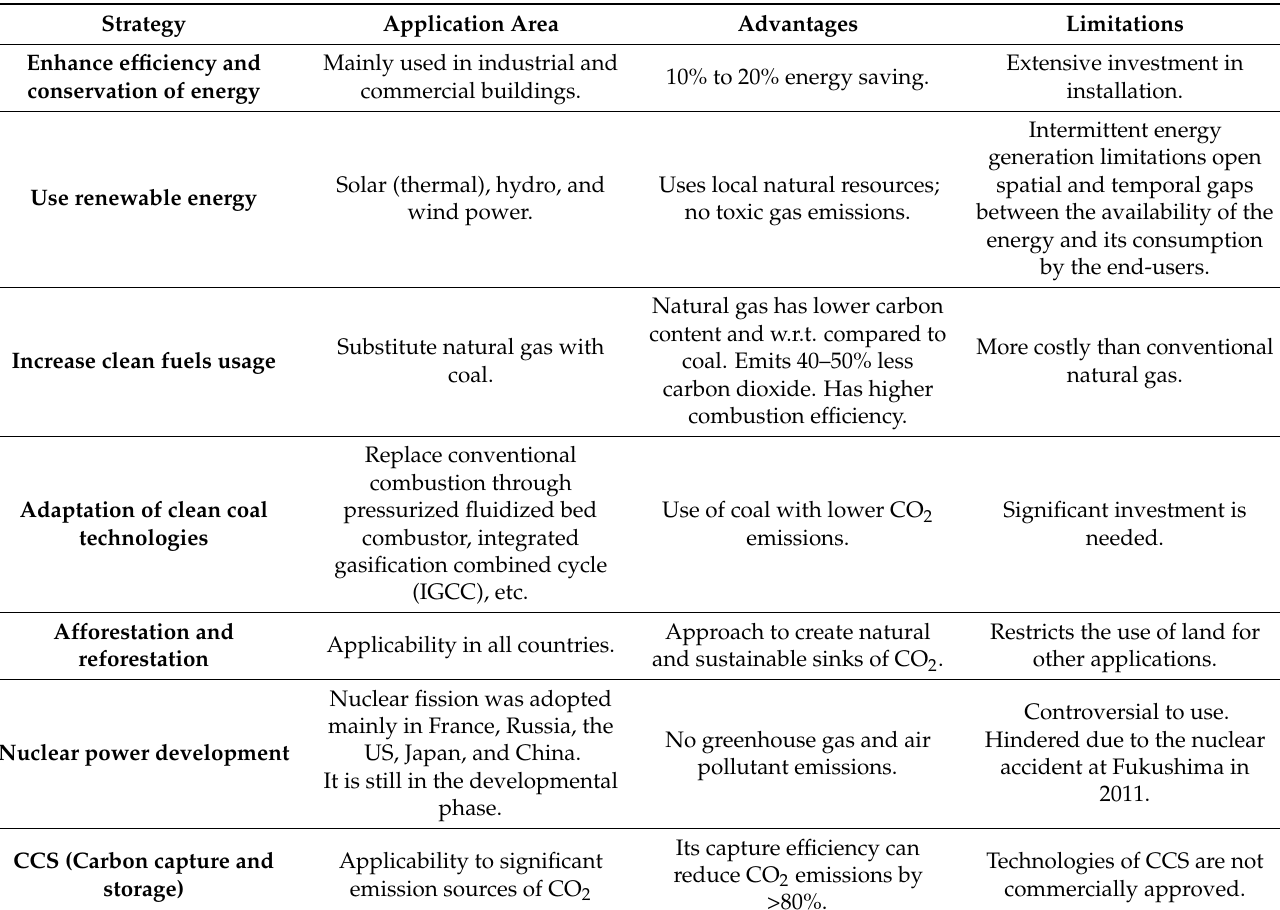
Table 1. Comparing the Carbon Dioxide Reduction Approaches